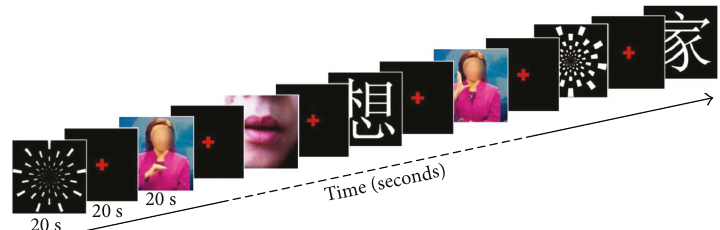
Figure 1: An example session of experimental paradigm. Subjects were presented alternating blocks of four di ff erent visual stimuli: checkerboard, words, sign language, and lip-reading. The order of presentation was pseudorandomly assigned. For each subject, there were 20 blocks (four stimuli × fi ve repetitions), with each stimulus presented for 20 s and the black screen sustained for 20 s as an interval. The whole experiment was separated into three sessions for the purpose of avoiding subject fatigue. Throughout a block, subjects were asked to either fi xate on a red cross at the center of the screen or concentrate on the visual stimuli. Questions were asked at the end of the experiment to ensure that subjects had paid attention to the visual stimuli (Supporting